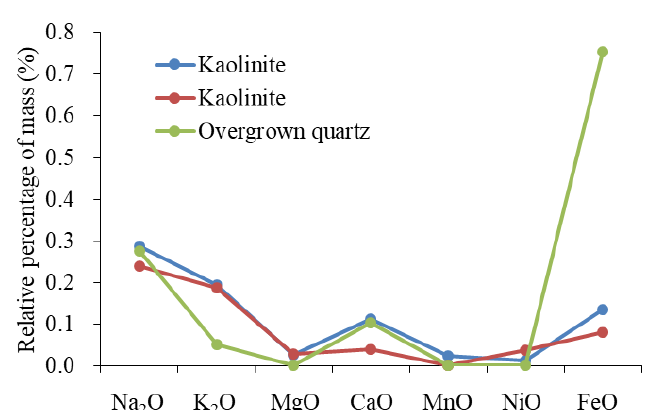
Figure 13. Composition distribution of particle coating and overgrown quartz.